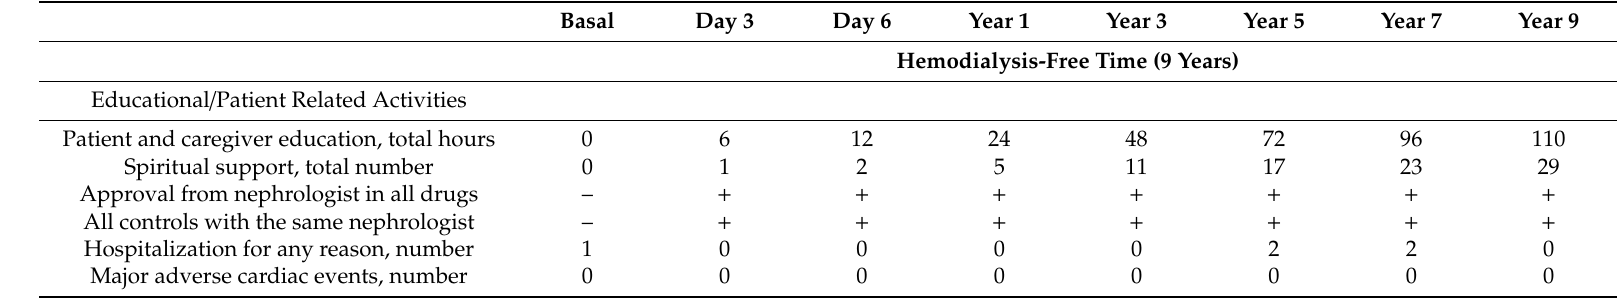
Table 2. Educational, clinical, and lifestyle parameters of the patient secondary to patient